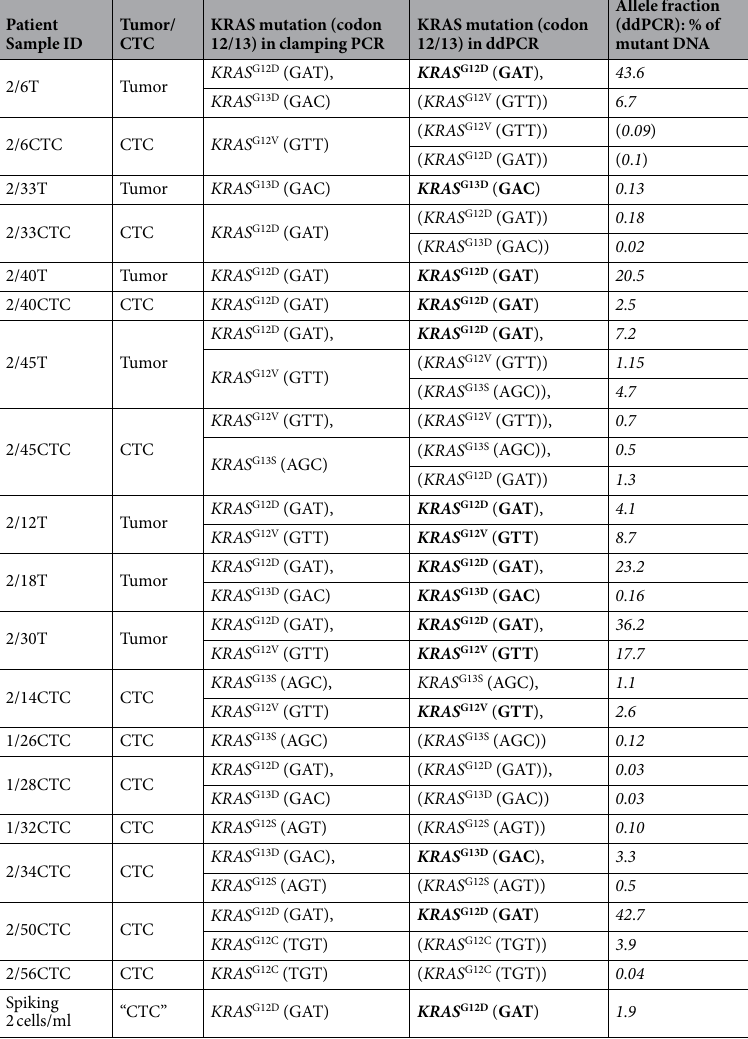
Table 4. Comparison of KRAS mutation results in clamping PCR and ddPCR in selected patient samples, mainly with multiple mutations in CTC or primary tumor. Statistically significant results are displayed in bold type; statistically non-significant results are displayed in parentheses. ddPCR: digital droplet